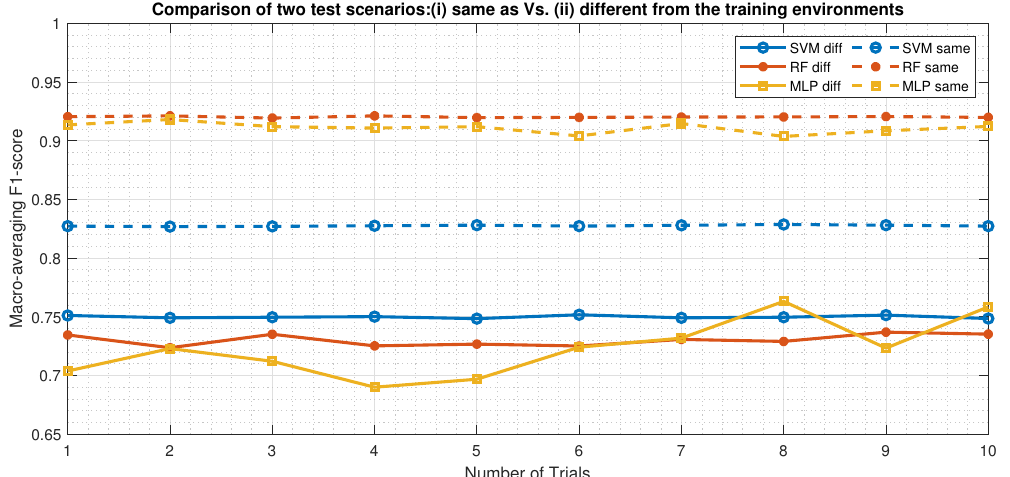
Figure 7. Performance comparison of the three evaluated classifiers based on the macro-averaging F1-score in two different scenarios: (i) dotted lines denote that the training and test data came from the same environment; (ii) solid lines denote that the training and test data came from different